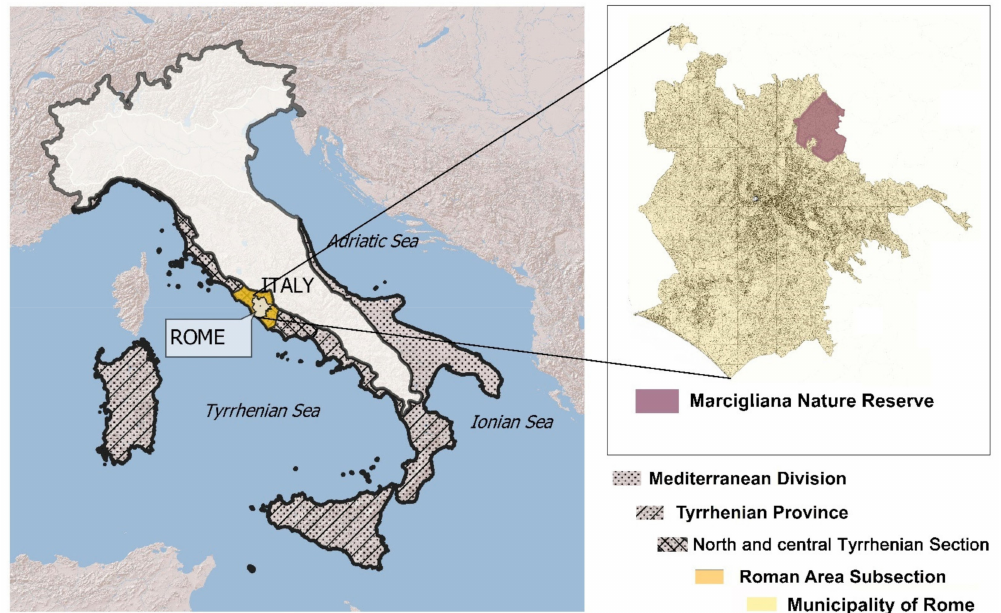
Figure 1. Study area. Ecoregional setting of the Municipality of Rome, from the division to the subsection level (on the left ), and location of the Marcigliana Nature Reserve within the Municipality of Rome (on the right